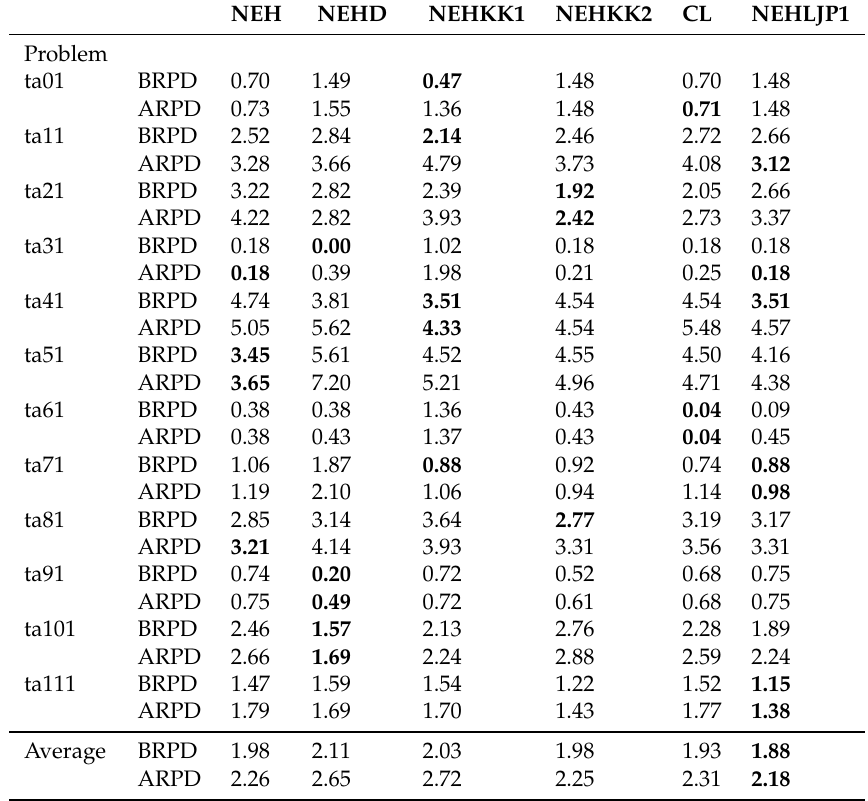
Table 5. Comparison of different variants of initialization algorithms. ARPD: average percentage relative deviation; BRPD: best percentage relative deviation. NEH NEHD